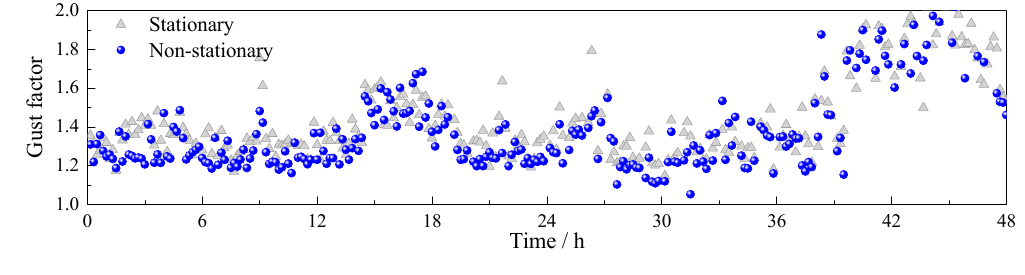
Figure 7. Comparison of stationary and non-stationary gust factor.